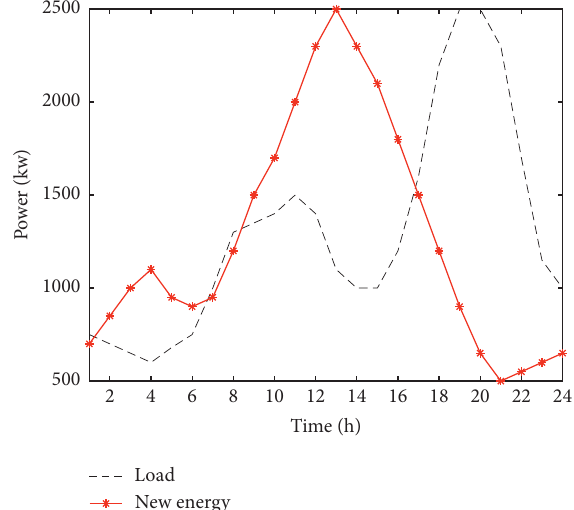
Figure 3: Load curve and renewable energy output curve.